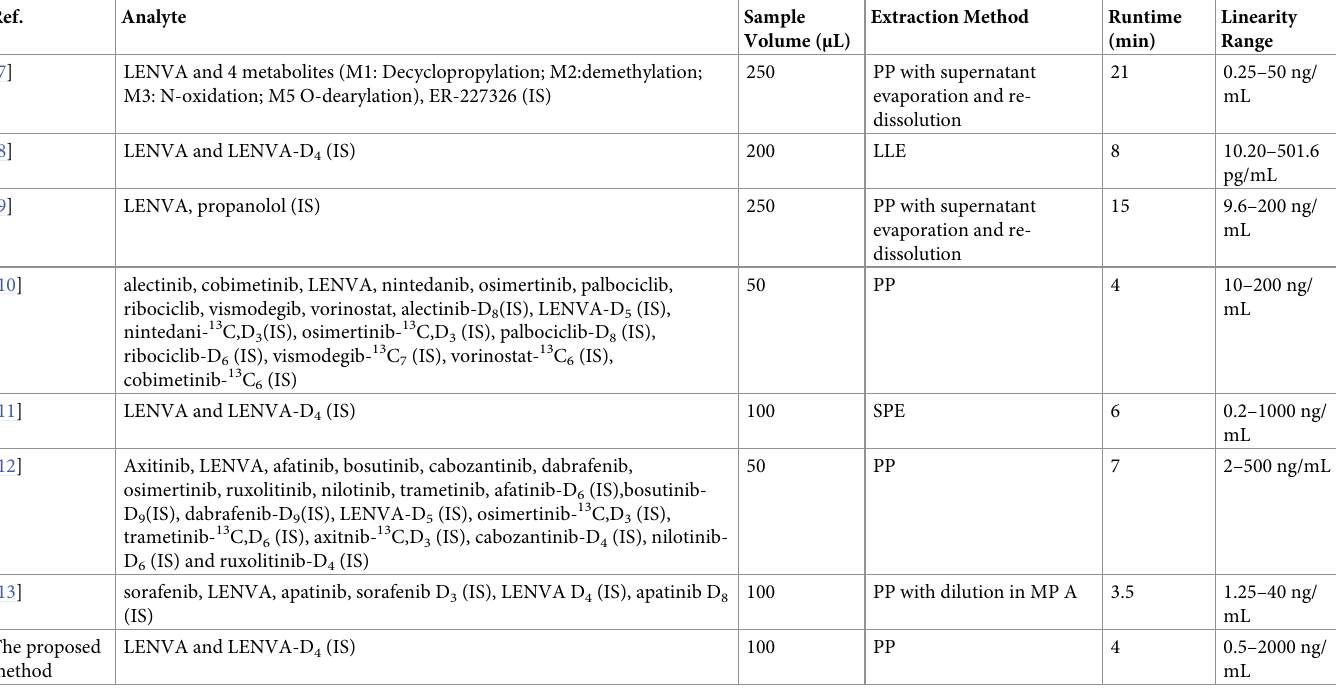
Table 1. Comparison between the proposed and previously reported LC-MS/MS methods for quantification of LENVA in human plasma.